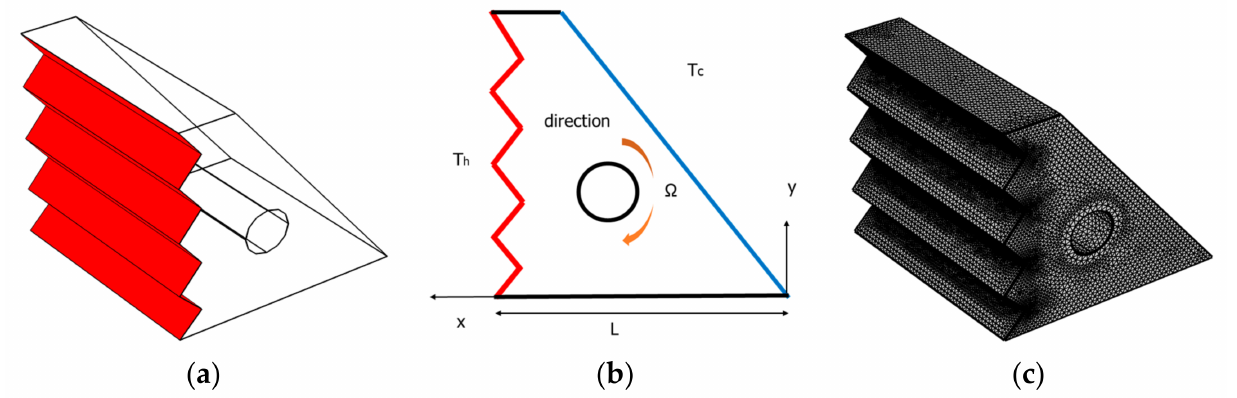
Figure 1. The computational domain: ( a ) 3D view of the enclosure; ( b ) 2D view of the geometry with illustrations of the boundary conditions. ( c ) Grid